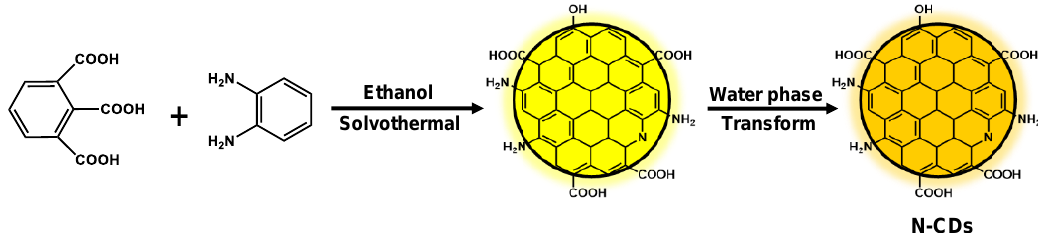
Water phase Transform N-CDs